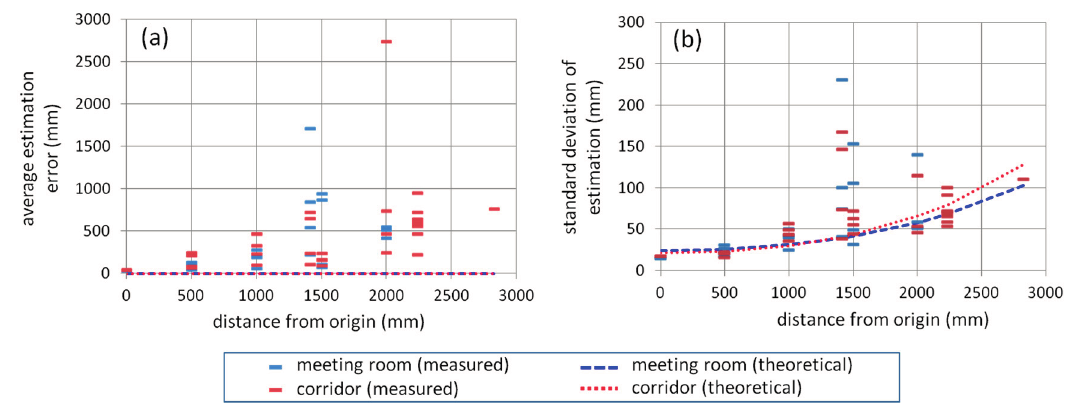
Figure 6. Relation between positioning error on x-y plane at each measurement position and distance of measurement position from the origin of coordinate system: ( a ) average of position estimation error and ( b ) standard deviation of estimated